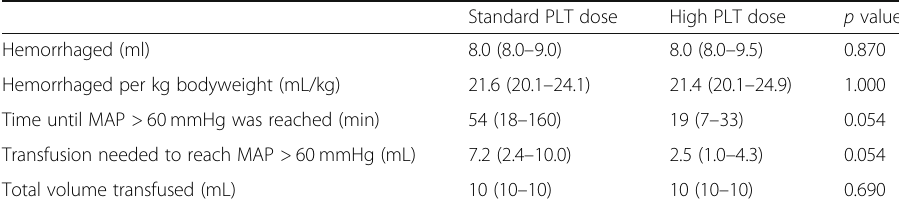
Standard PLT dose High PLT dose p value